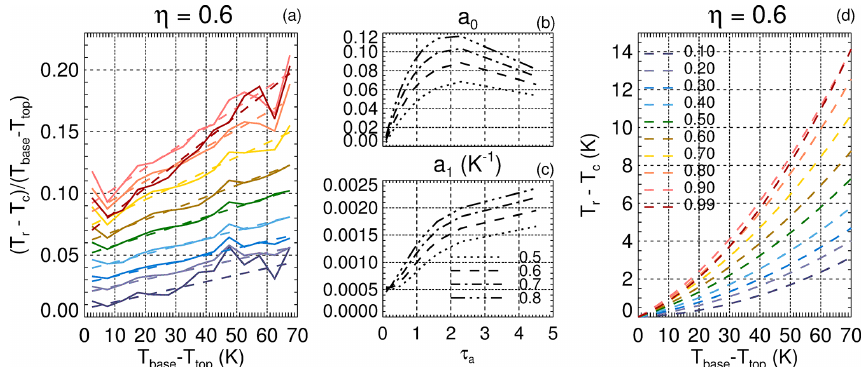
Figure 6. V4 correction functions of ice cloud radiative temperature: (a) ( T r − T c ) / ( T base − T top ) vs. T base − T top for effective emissivities between 0.1 and 0.99 and η = 0 . 6. The solid lines are median values from statistical analyses and the dashed lines are regression lines; (b) intercept and (c) slope of the regression lines vs. τ a , 12 for η between 0.5 and 0.8; (d) resulting V4 corrections T r − T c vs. T base − T top for effective emissivities between 0.1 and 0.99 and η = 0 . 6. Results are for channel 12.05µm. Table 3. Statistics (median, mean, standard deviation (SD), and mean absolute deviation (MAD)) of the T r − T c correction at 12.05µm and of correction errors for ε eff , 12 equal to 0.2, 0.6, and 0.99, using η equal to 0.5 and 0.8. T r − T c correction (K) Correction error